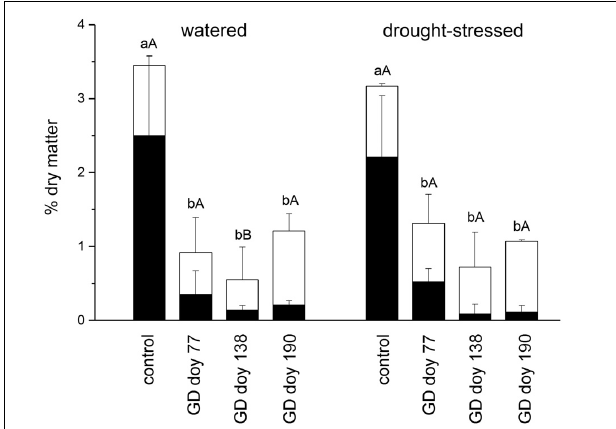
FIGURE 4 | Mean concentration of starch (black bars) and soluble sugar (open bars) at the end of the study period in the coarse root of watered and drought-stressed trees. Significant effects of girdling within a soil moisture treatment are indicated by different letters (Mann–Whitney U -test; lower case letters: starch, P ≤ 0.001; upper case letters: soluble sugar, P ≤ 0.01). Bars indicate standard